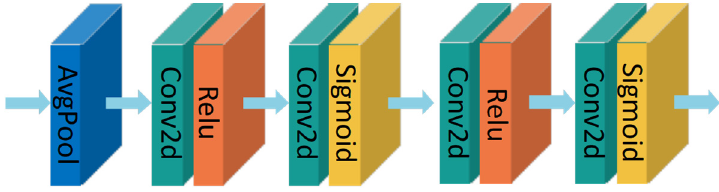
Figure 4. Structural diagram of the feature attention module.